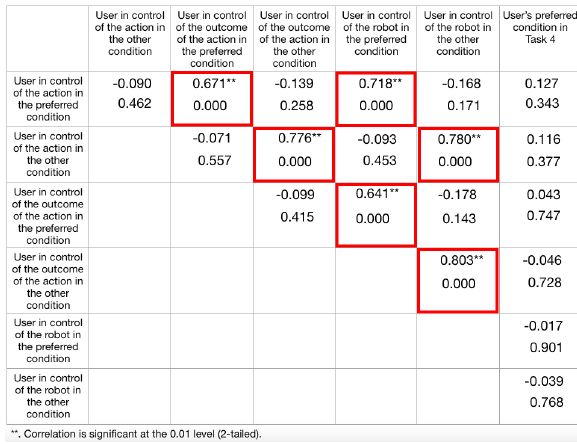
Figure 17: Correlation table for Task 4 "Biscuits" between the par- ticipant’s preferred condition and the participant’s perception of control for their preferred condition and their non-preferred condi- tion.